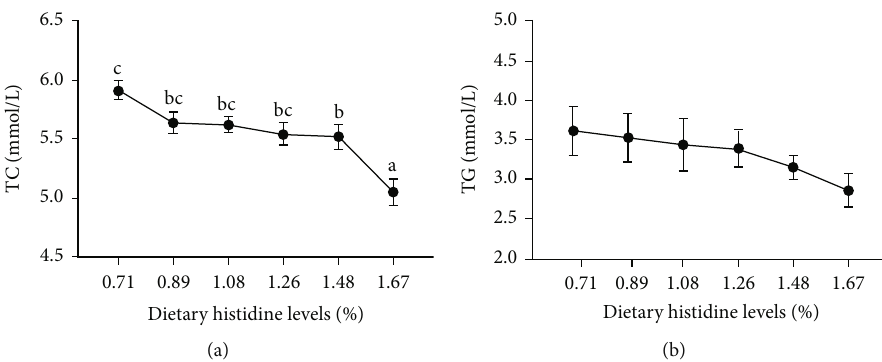
Figure 3: Serum biochemical indices of juvenile largemouth bass fed with di ff erent levels of dietary histidine. Data are expressed as means with S.E.M.; value with di ff erent superscripts are signi fi cantly di ff erent ( P < 0 : 05 ).